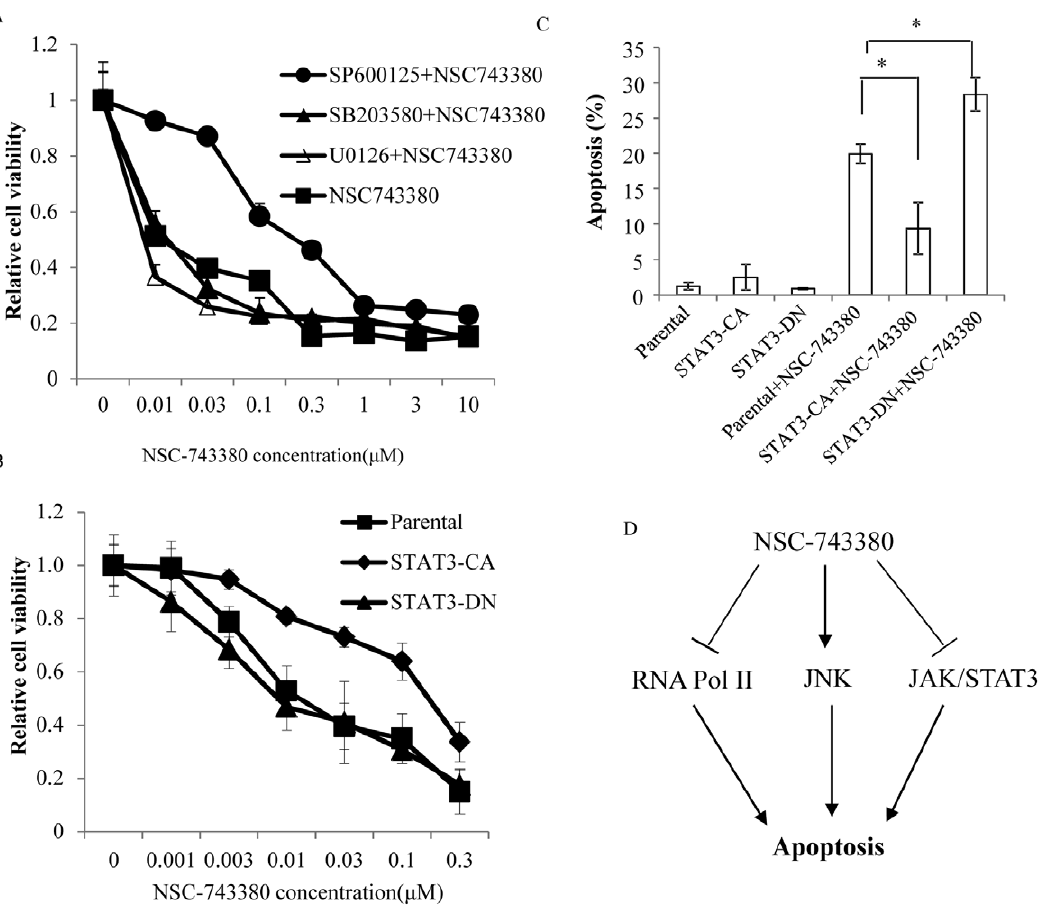
Figure 6. Effect of JNK inhibitor and constitutive STAT3 on NSC-743380-induced cell killing. A) A498 cells were pretreated with 10 m M of JNK inhibitor SP600125, p38 MAP kinase inhibitor SB203580 or Erk inhibitor U0126 for 2 hours, and then analyzed for their susceptibility to NSC- 743380. Dose response to NSC-743380 was determined by the SRB assay. Values represent the means 6 SD from three independent experiments. B) A498 cells were transfected with a plasmid expressing STAT3-CA or expressing STAT3-DN. After selection with G418, cells expressing STAT3-CA or STAT3-DN were pooled together. Parental, STAT3-CA–transfected, or STAT3-DN–transfected A498 cells were then analyzed for their susceptibility to NSC-743380. Dose response to NSC-743380 was determined by the SRB assay. C) Percentage of apoptotic cells in parental and STAT3-CA or STAT3-DN transfected A498 cells at 12 h after treatment with 1 m M NSC-743380. * represents a P value less than or equal to 0.05. D) Putative mode of action by NSC-743380.